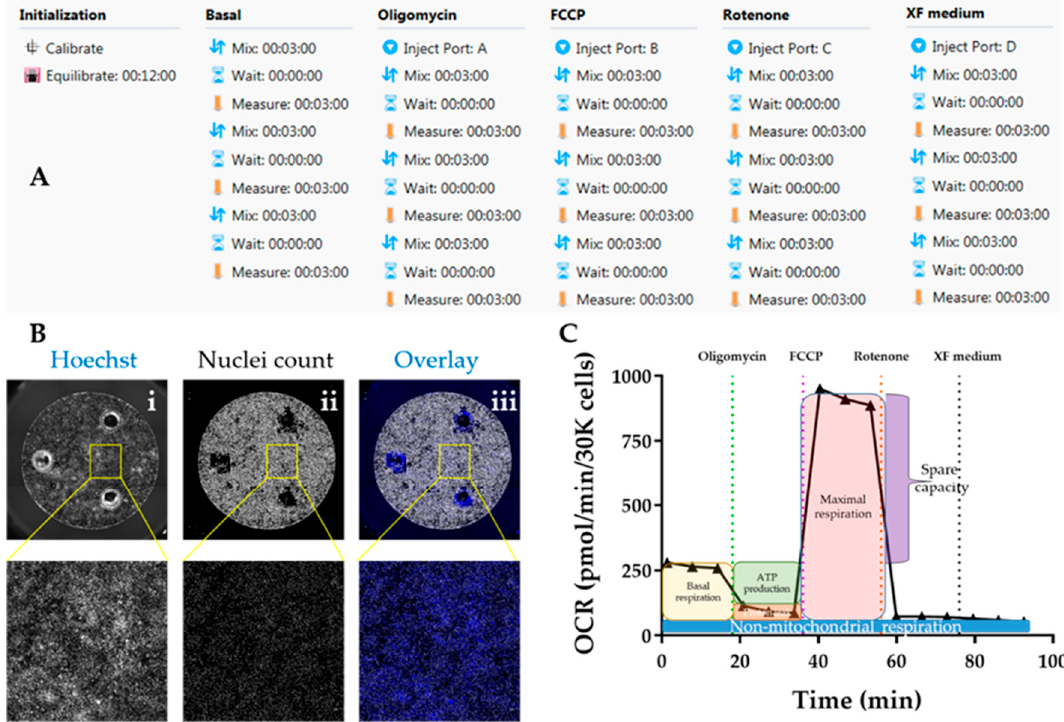
Figure 7. Evaluation of mitochondrial respiration using Seahorse platform. ( A ) Protocol summary for mitostress test using the Seahorse assay™. ( B ) Representative micrographs detailing normalisation by automated quantification of cell nuclei in Cellavista™ plate imager ((i) Hoechst staining of nuclei; (ii) quantification of individual nuclei; (iii) overlay). ( C ) Sample graph for oxygen consumption rate (OCR) over time following the Seahorse mitostress kit, highlighting the different mitochondrial respiration parameters.